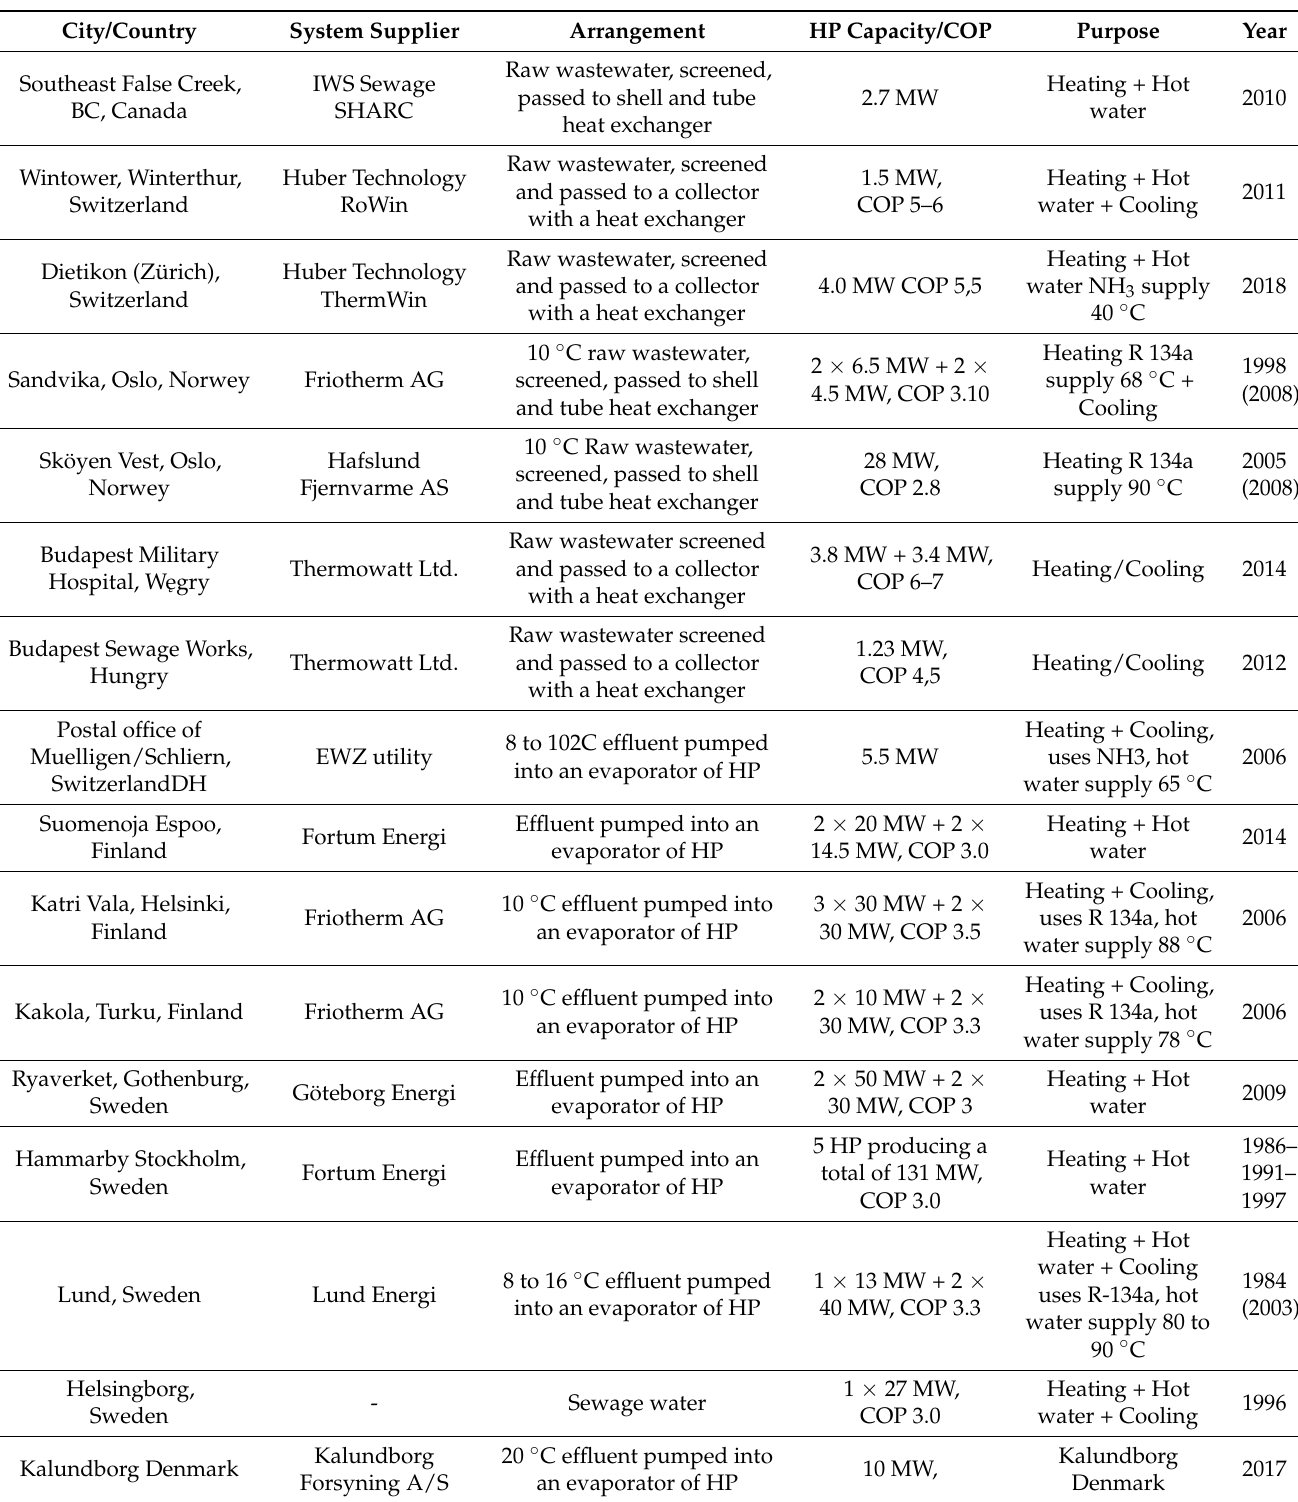
Table 1. Heat recovery from sewage—examples from around the world